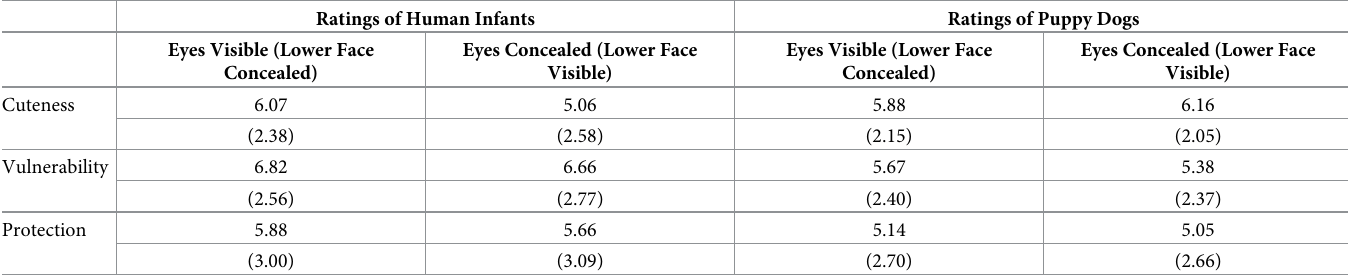
Table 3. Experiment 3: Mean ratings (with standard deviations in parentheses) of human infants and puppy dogs, as a function of whether their eyes were visible or